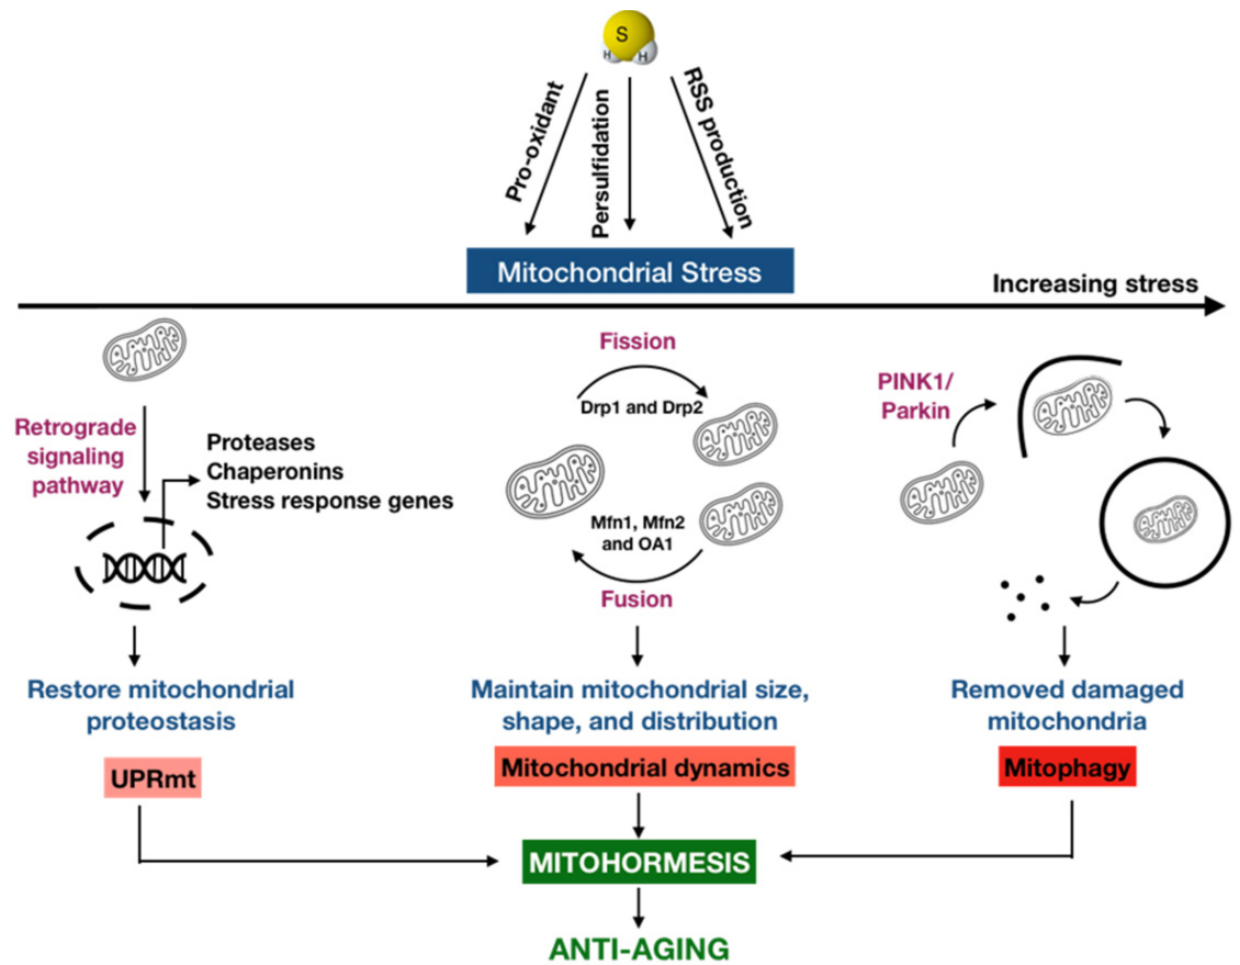
Figure 2. A new possibility of H 2 S in anti-aging via mitohormesis. Mitohormesis refers to as an adaptive response through which the induction of mild or moderate mitochondrial stress can promote the viability and health of a cell, tissue, or organism. Depending on the severity of the perceived stress, there are varying hormetic responses existing in the mitochondria called mitochondrial stress response to adapt to different stress levels. The mitochondrial unfolded protein response (UPR mt ) is activated as the first line of defense for mitigating the stress, which induces a retrograde signaling pathway from the mitochondria to the nucleus, leading to the expression of proteases, chaperonins, and many stress response genes to degrade the unfolded or misfolded proteins and re-establish the mitochondrial protein homeostasis. In addition, mitochondria are highly dynamic organelles that undergo coordinated cycles of fission and fusion, referred to as mitochondrial dynamics, to maintain their size, shape, and distribution. When the stress level is increased, mitochondrial dynamics comes into action. When the mitochondrial stress level is overwhelmed, a selective type of autophagy targeting the damaged mitochondria for degradation, termed mitophagy, takes place. H 2 S can be an important regulator for these mitochondrial stress responses, both directly and indirectly, as this gas itself may be a pro-oxidant by stimulating the Fenton reaction or it may undergo the sulfide oxidation pathway in the mitochondria to generate highly reactive sulfur species (RSS), which can be further oxidized or can modify cysteine residues via